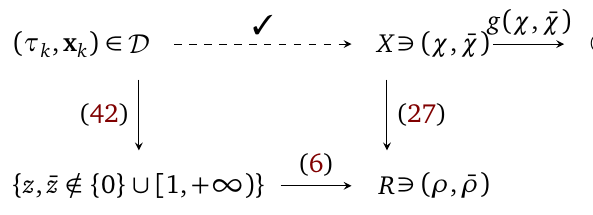
Figure 3.1: The diagram of maps in